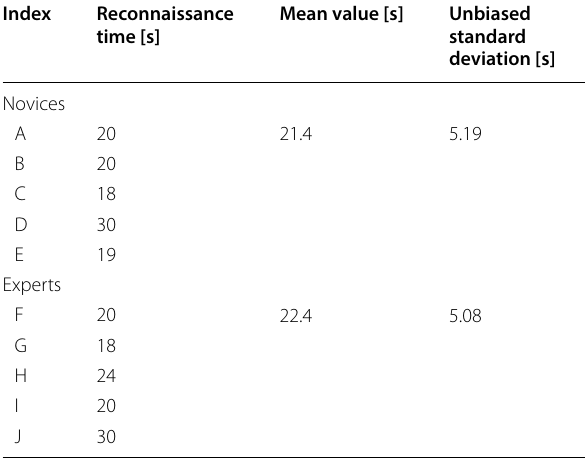
Table 9 Reconnaissance times of novices and experts for thoroughly checking one side of the commercial